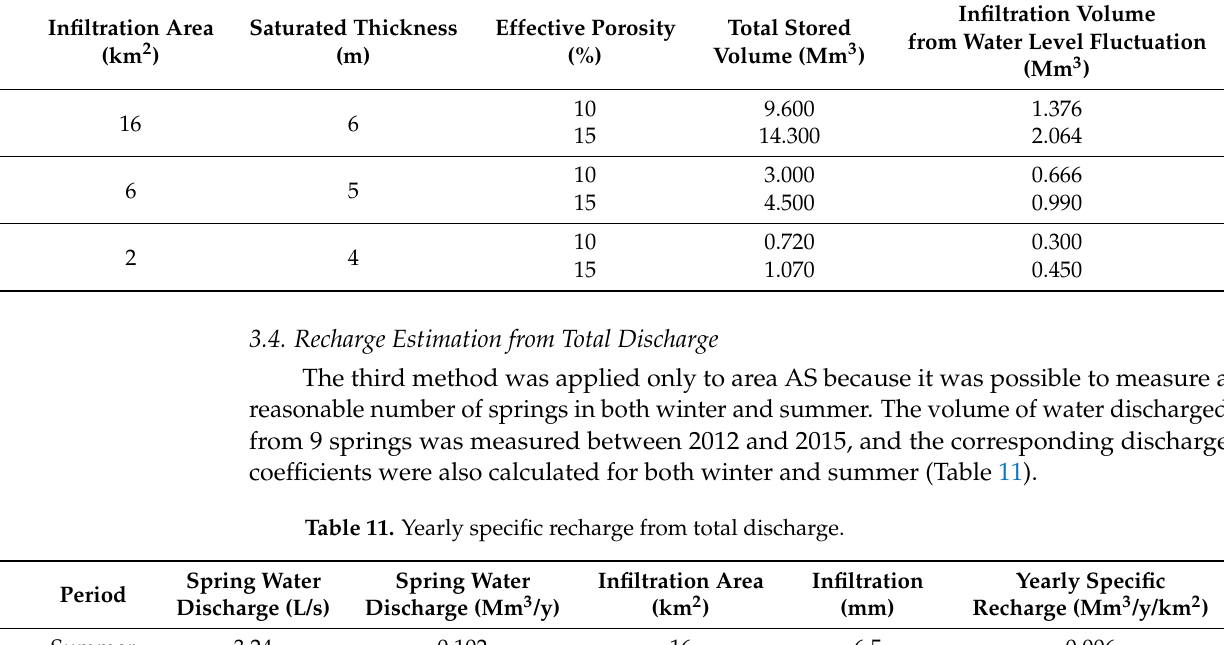
Table 10. Estimation of the water resource for three sample sites considering an average saturated thickness in the sandy-gravel association of the arenaceous complex.